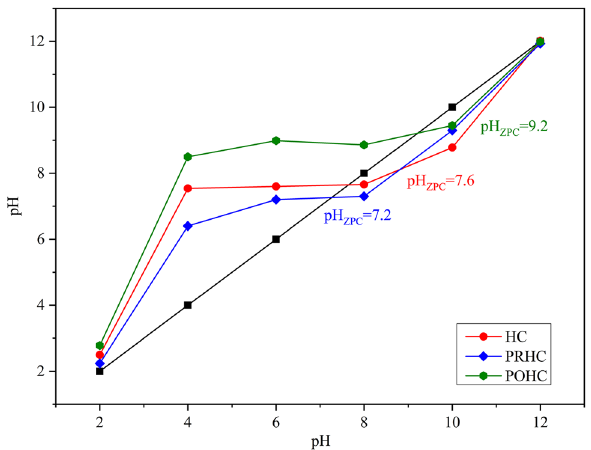
Figure 4. Point of Zero charge for